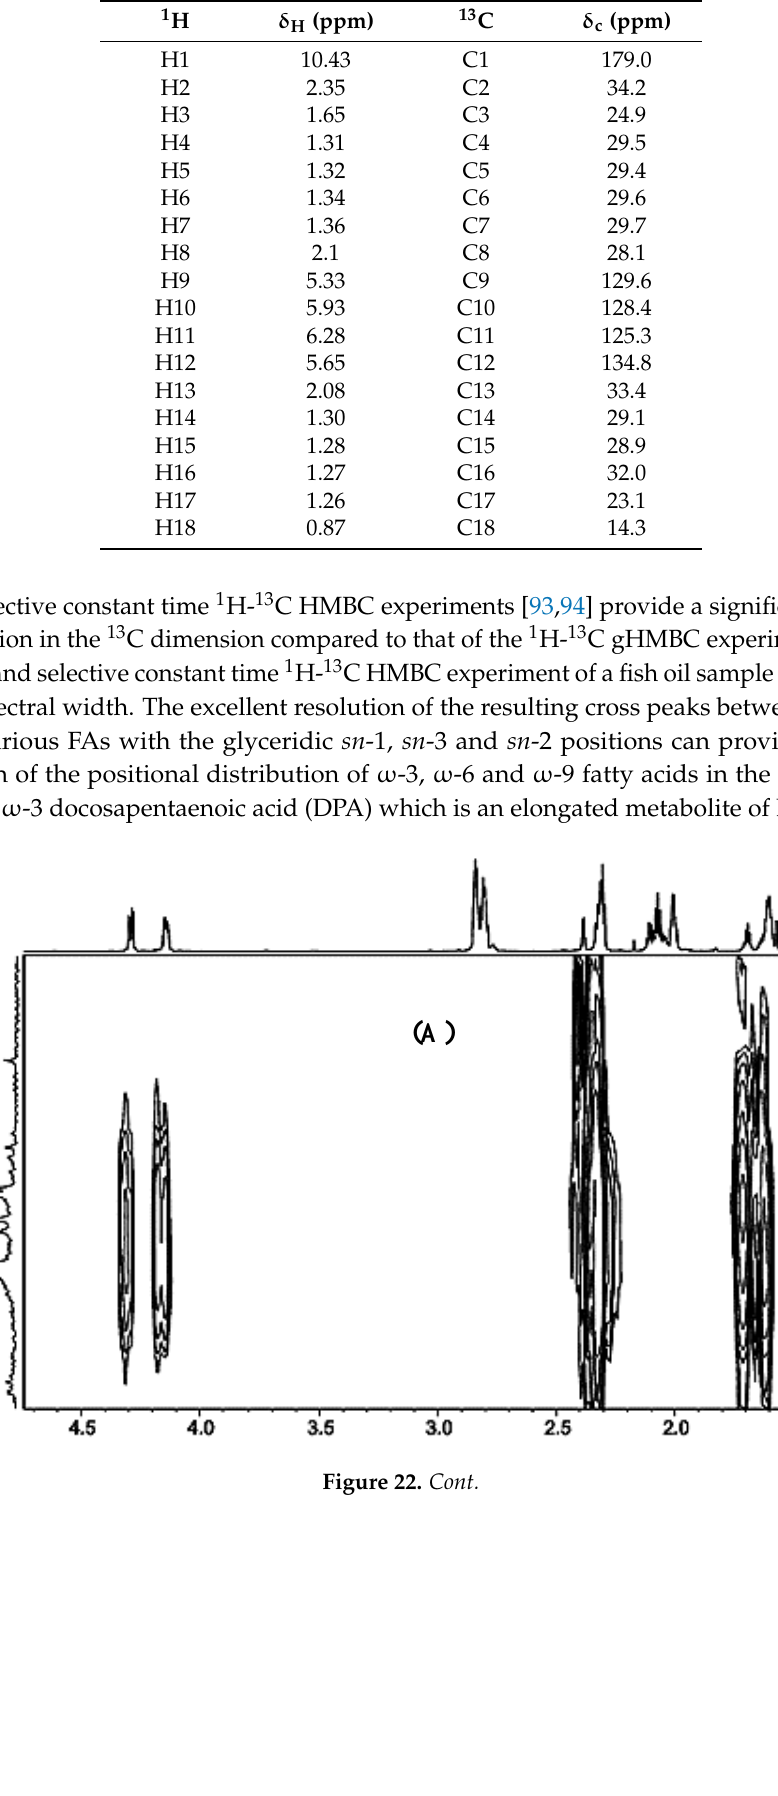
Table 19. 1 H and 13 C peak assignments of the (9- cis , 11- trans ) 18:2 CLA isomer in CDCl 3 (solution conditions the same as in Figure 16).